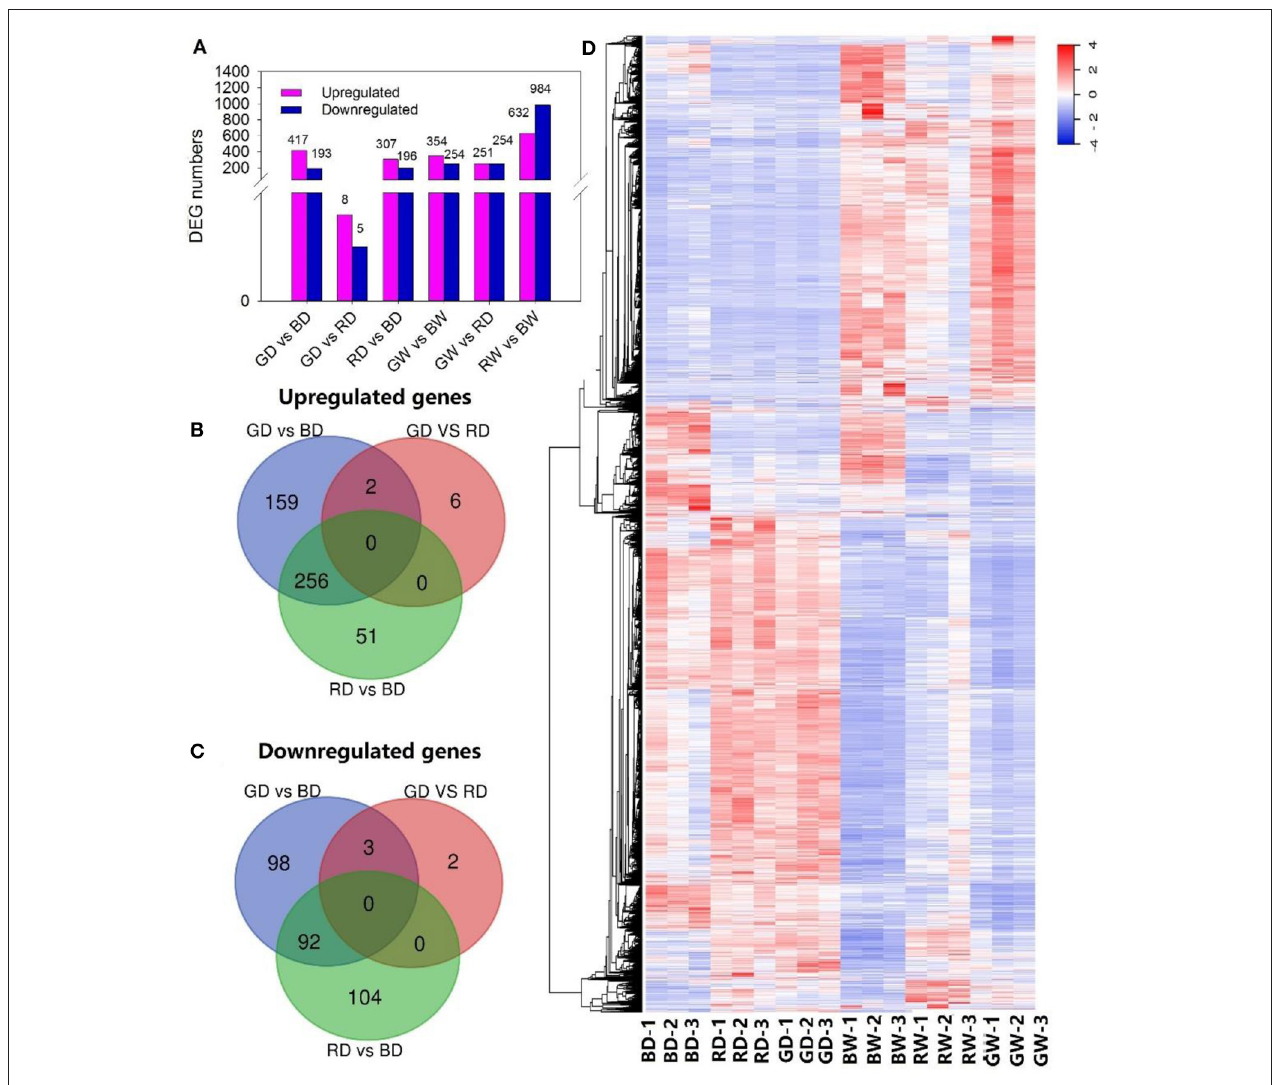
FIGURE 4 | The changes in gene expression profiles of tomato treated with different light spectra and water conditions. (A) , The number of DEGs between treatments; (B,C) , Venn diagram presenting up-regulated and down-regulated genes among plants exposed to different light spectra under drought conditions; (D) , Hierarchical clustering of DEGs, fragments per kilobase of transcript per million fragments mapped (FPKM), and relative expression of DEGs between different light and water treatments were calculated as log 2 (FPKM) of differentially expressed genes, log 2 (FPKM) of differentially expressed genes were calculated. A scale indicating the color assigned to log 2 (FPKM) is shown to the right of the